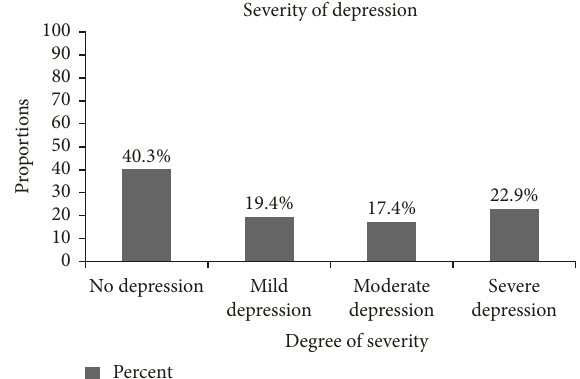
Figure 2: Severity of depression of respondents on depression and associated factors among adult inpatients in Harari region hospitals, Eastern Ethiopia, 2017 ( 𝑛 = 489